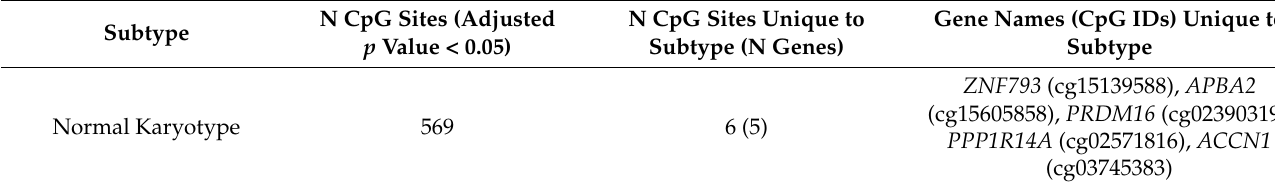
Table 3. Top selected CpGs and genes per subtype based on a one-vs.-rest CpG Site Selection with adjusted p -value threshold